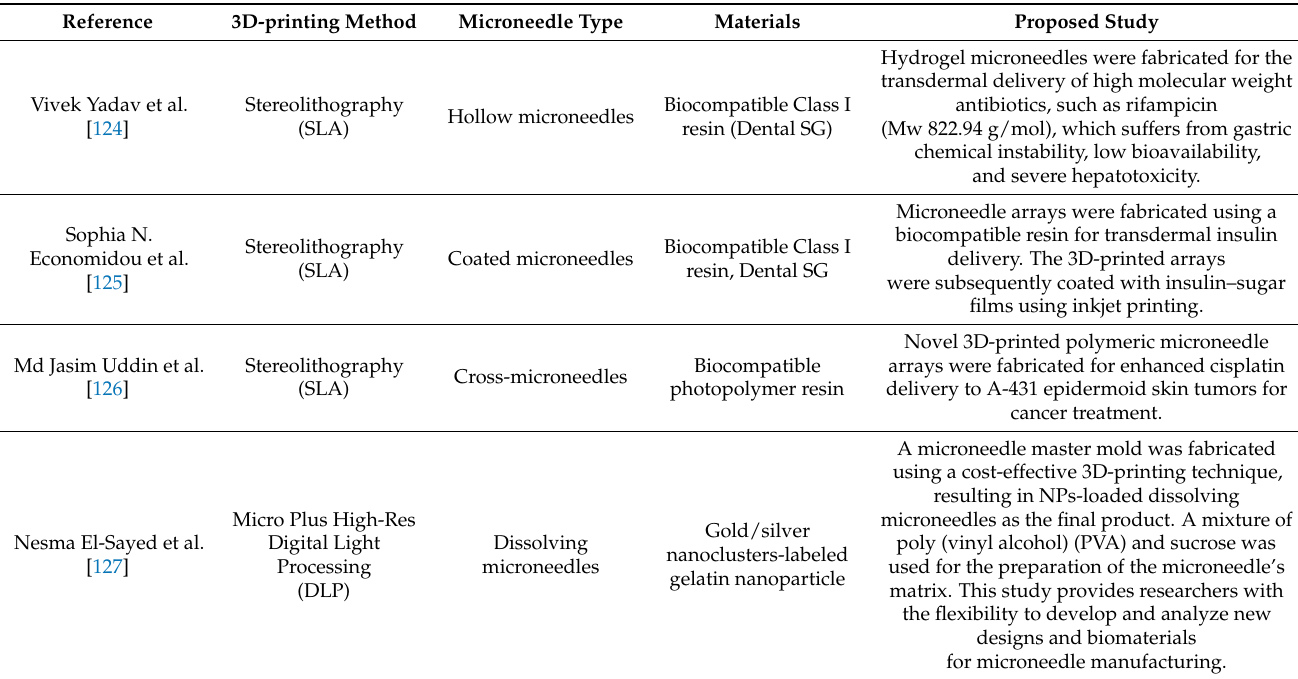
Table 5. Additive manufacturing of microneedles in the past